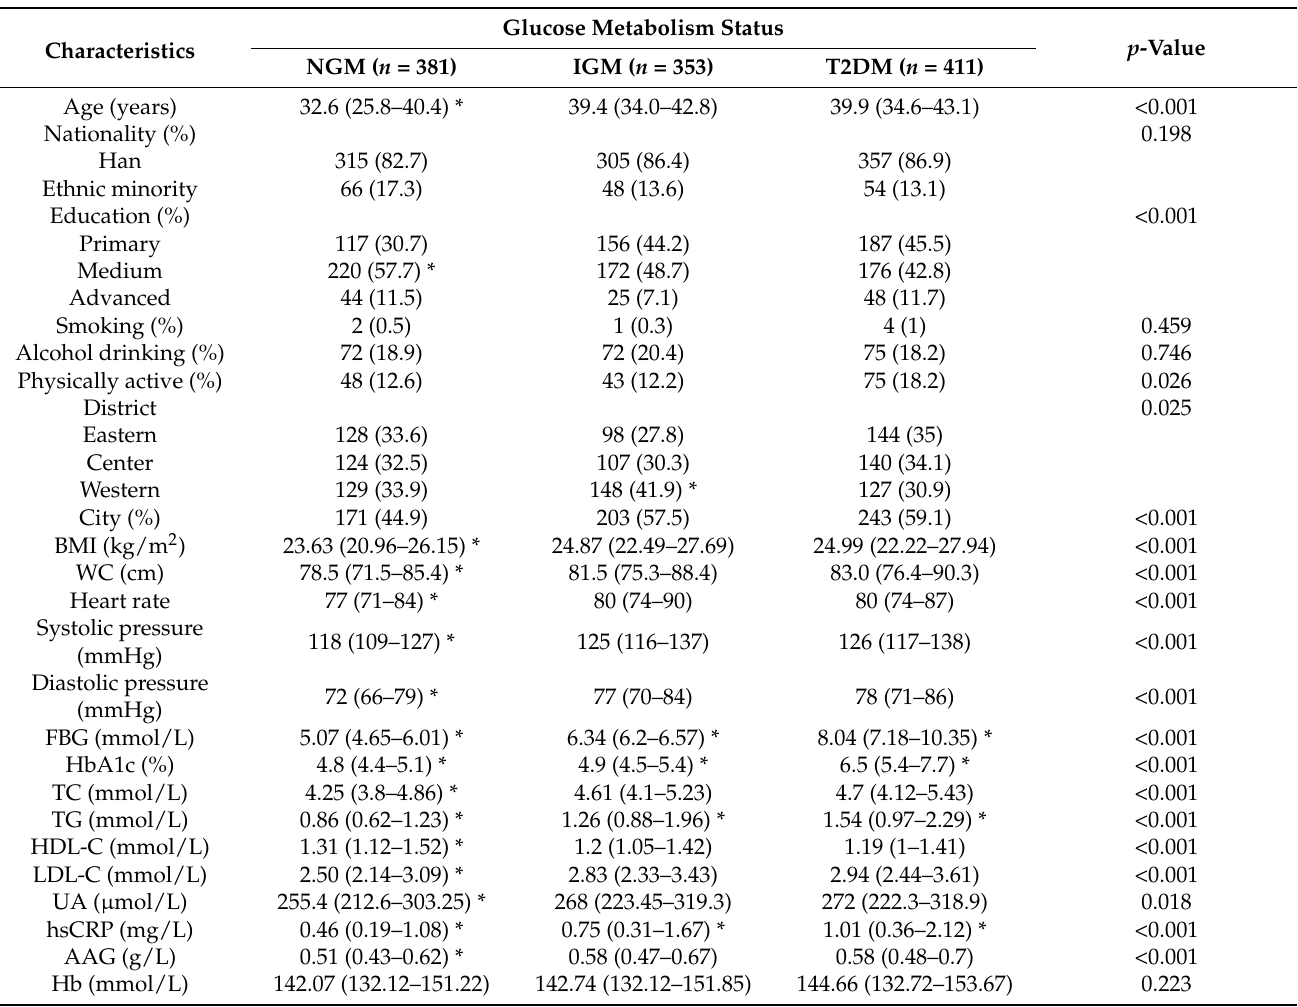
Table 1. General characteristics of the study population ( n = 1145, medians and interquartile ranges